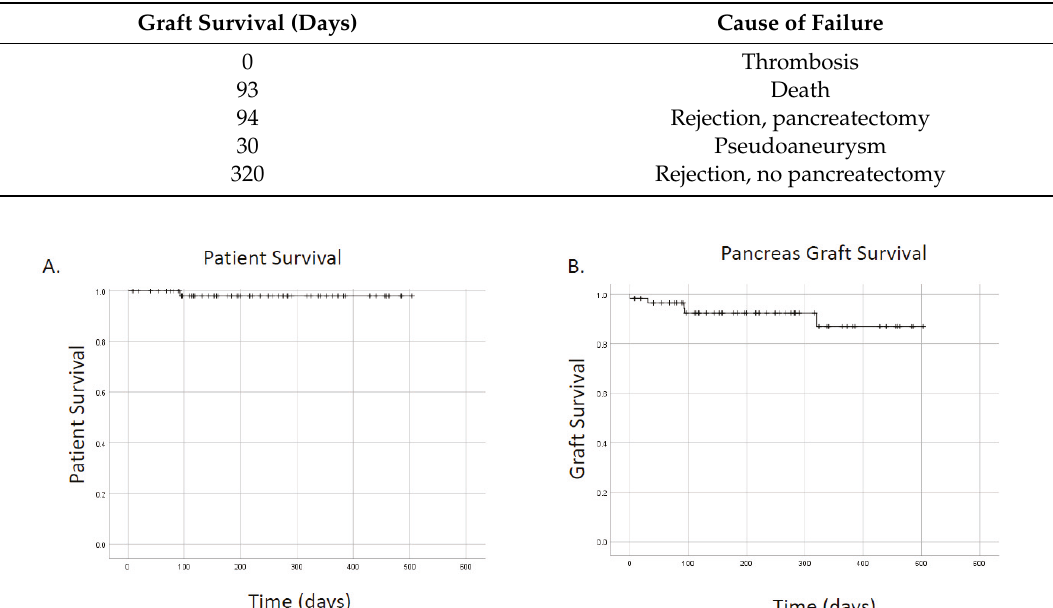
Figure 2. Graft survival and troponin elevation after pancreas transplantation. Graft survival was worse for patients who also experienced post-transplantation troponin elevation ( p = 0.025).